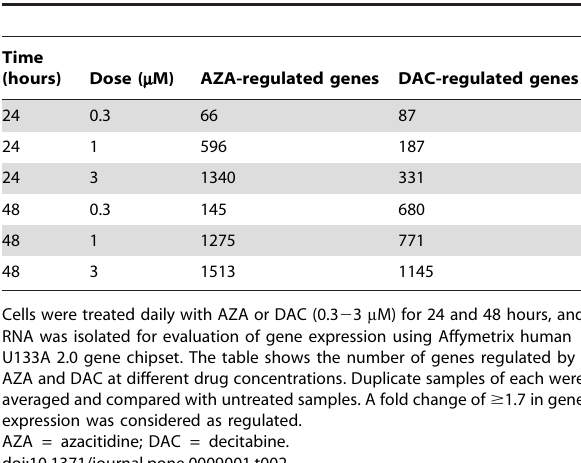
Table 2. Number of genes regulated by AZA and DAC in KG-1a cells.